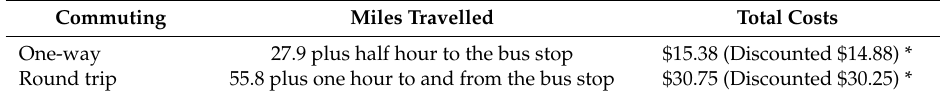
Table 7. Commuting cost associated with travelling by SCRTD